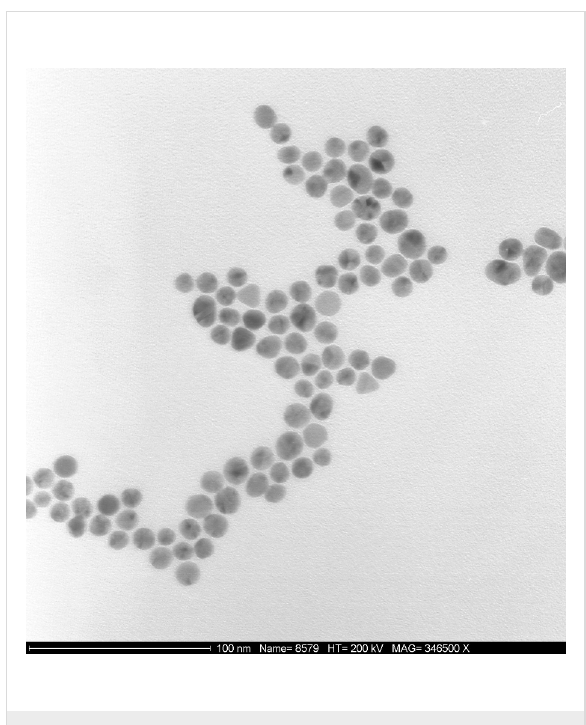
Figure 11: 400 nm × 400 nm TEM image of 25 nm diameter gold nanoparticles.